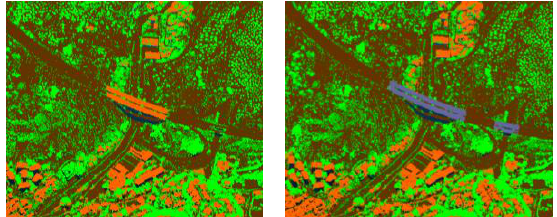
Figure 3 – Comparison between before and after detecting bridge (in grey). Ground points are in brown, building points in orange and vegetation in